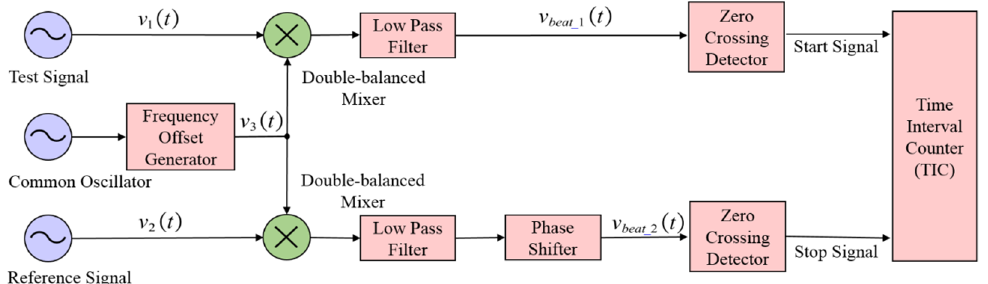
Figure 1. A schematic diagram of the DMTD method.